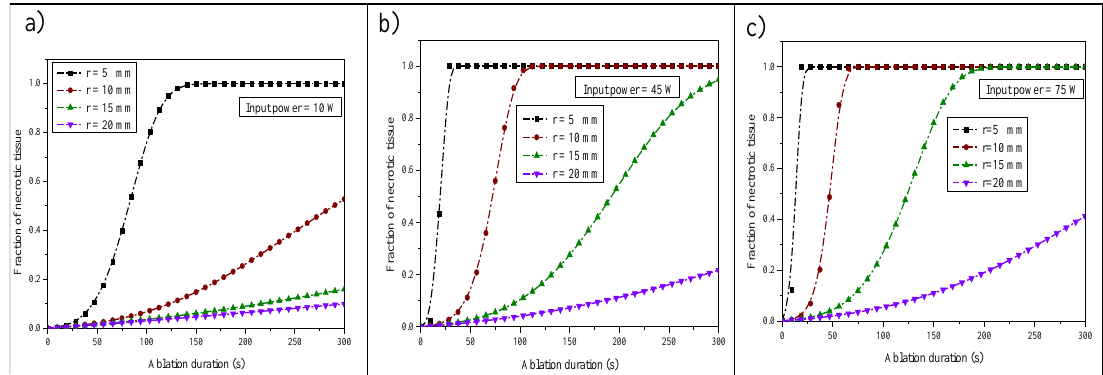
Figure 11. Comparison of the four position fraction of necrotic tissue during the ablation thermal for three values of input microwave power, ( a ) 10 W, ( b ) 45 W and ( c ) 75 W.